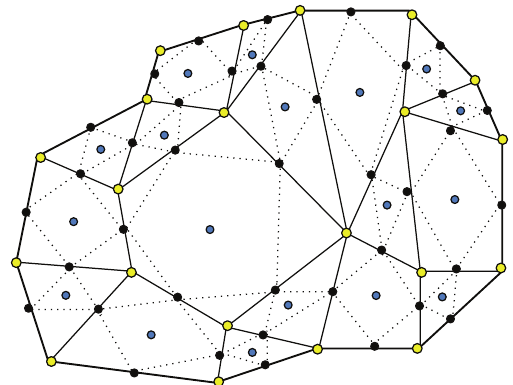
Figure 2: A primary mesh (full lines) and the associated auxiliary mesh (dotted lines), including edge-points and cell-points, respec- tively, in black and blue